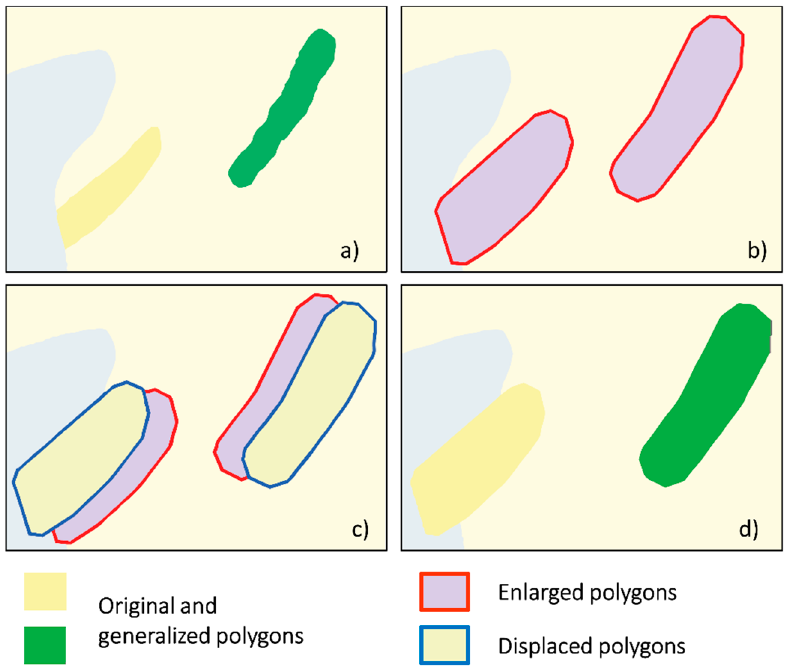
Figure 6. Displacement triggered by polygon enlargement. ( a ) Original polygons that need to be enlarged. ( b ) Enlarged polygons, in conflict with object separation. ( c ) Overlay of enlarged and displaced polygons. ( d ) Displaced polygons.